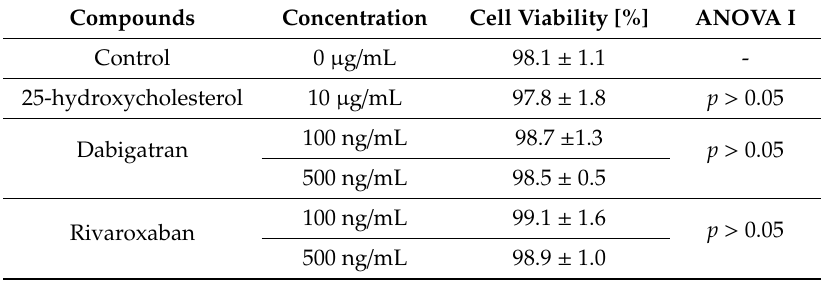
Table 1. The level in the viability level of human HUVECs was determined by the Trypan Blue dye exclusion test. HUVECs were induced by 25-hydroxycholesterol (10 µ g / mL), dabigatran (100 ng / mL and 500 ng / mL) and rivaroxaban (100 ng / mL and 500 ng / mL). Mean ± SD was calculated from nine individual experiments. Significant di ff erence from negative controls was indicated by * p < 0.05. Statistical analysis was conducted using one-way ANOVA and post-hoc Tukey’s test.